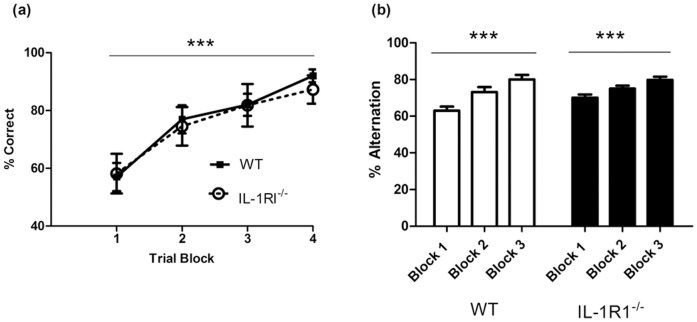
Performance of IL-1R1−/− mice versus WT on a visuo-spatial reference memory task and a working memory task.(a) Visuo-spatial reference memory was assessed using the Y-maze across 20 trials (5 trials per trial block) in IL-1R1−/− (n = 11) compared to WT mice (n = 20). (b) Working memory was assessed in 1L-1R1−/− (n = 11) and WT (n = 15) by T-maze alternation, over 12 days, 10 trials per day with block 1 representing performance of mice on days 1–4, block 2 the performance of mice on days 5–8 and block 3 the performance of mice on days 9–12. Data are shown as mean±SEM and were analysed by two-way repeated-measures ANOVA with strain as between subjects factor and trial block as within subjects factor. Main effects of trial block for both mazes are depicted by ***p<0.001.